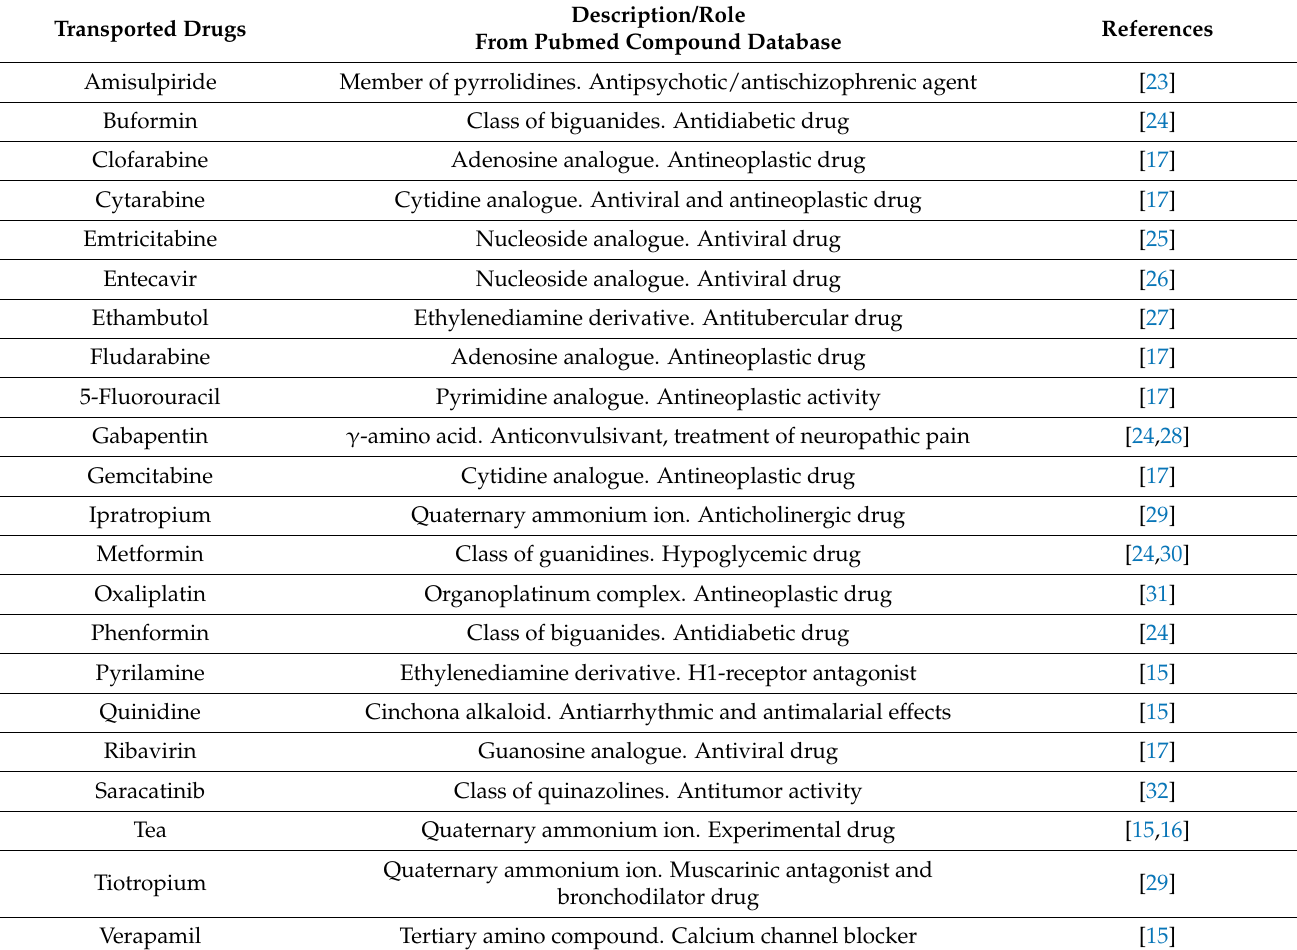
Table 2. Drugs transported by OCTN1. For each drug, Description/Role and one or more References are